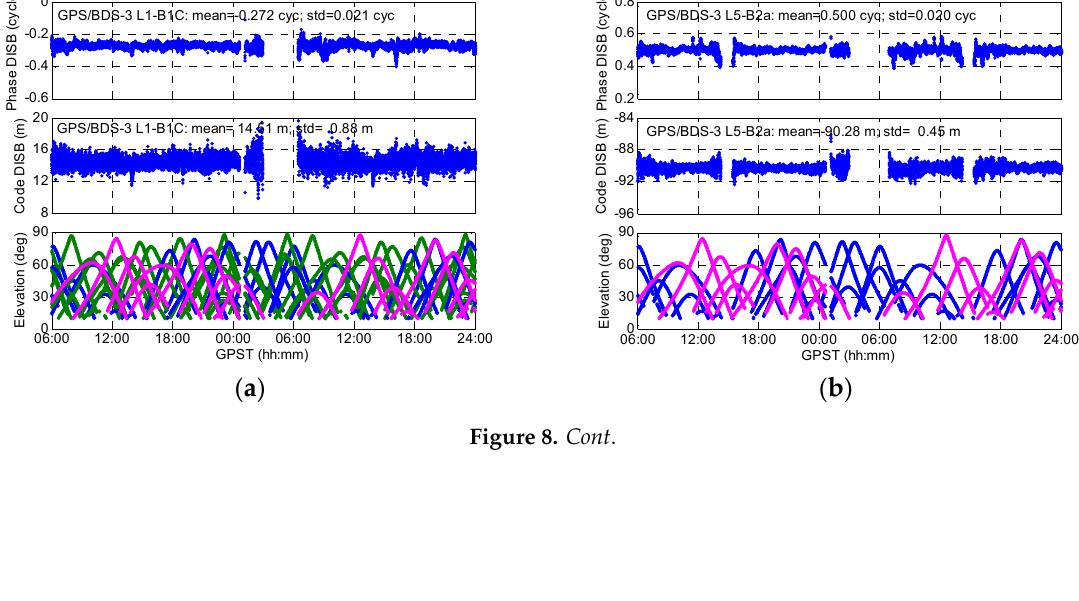
Figure 8. Estimated ISBs between GPS/BDS-3 L1-B1C ( a ), L5-B2a ( b ), and Galileo/BDS-3 E1-B1C ( c ), E5a-B2a ( d ) for short baseline based on different receiver types (iGMAS and M300Pro receivers).